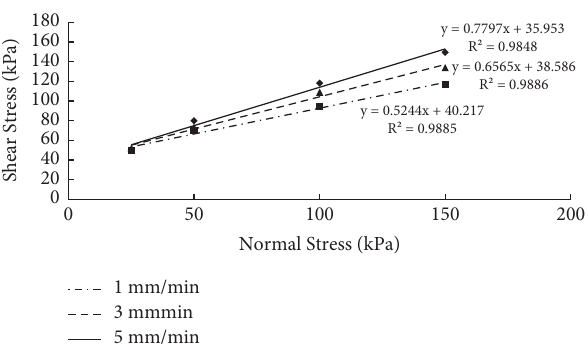
Figure 14: Fitting curve of shear strength under diferent shear rates.